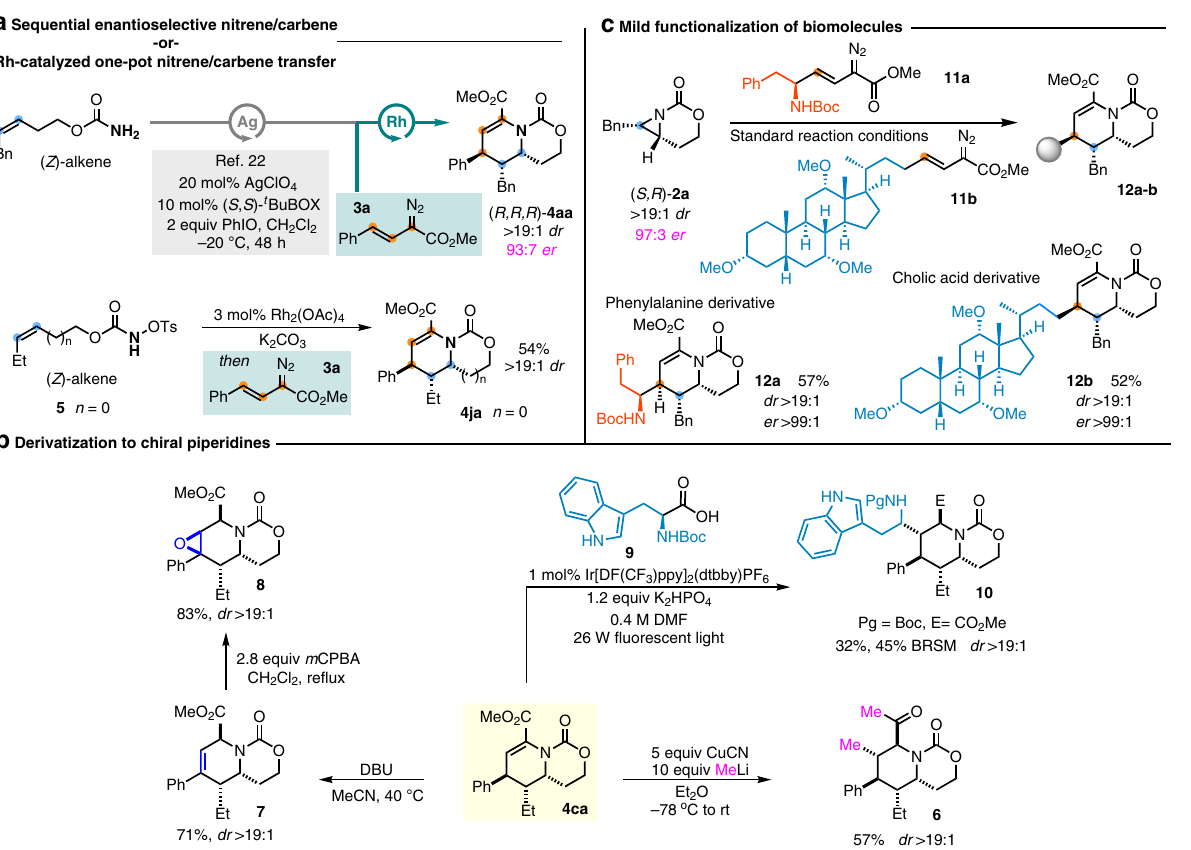
Fig. 4 Tandem nitrene/carbene chemistry and derivatization of products. a Streamlining the nitrene/carbene transfer sequence. b Late-stage functionalization of complex molecules. c Further derivatization of